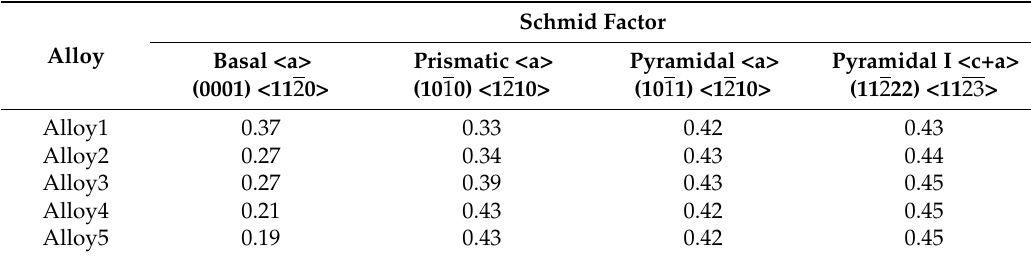
Table 4. Schmid factors of various slip systems of investigated